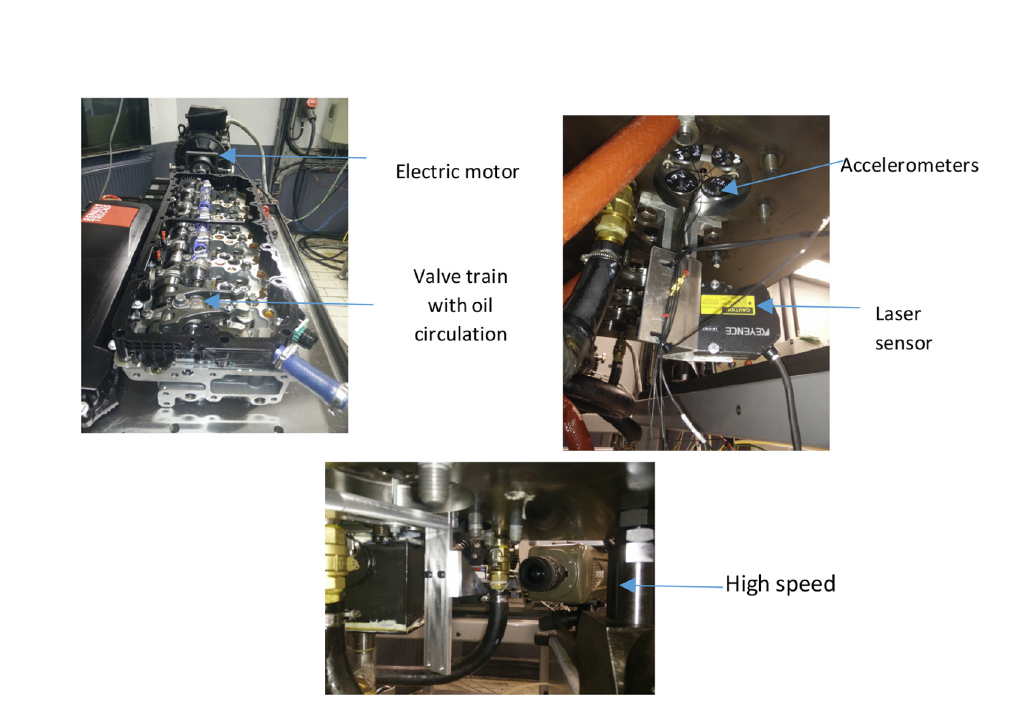
Fig. 7. Valve motion rig used to characterize real valve-seat contact